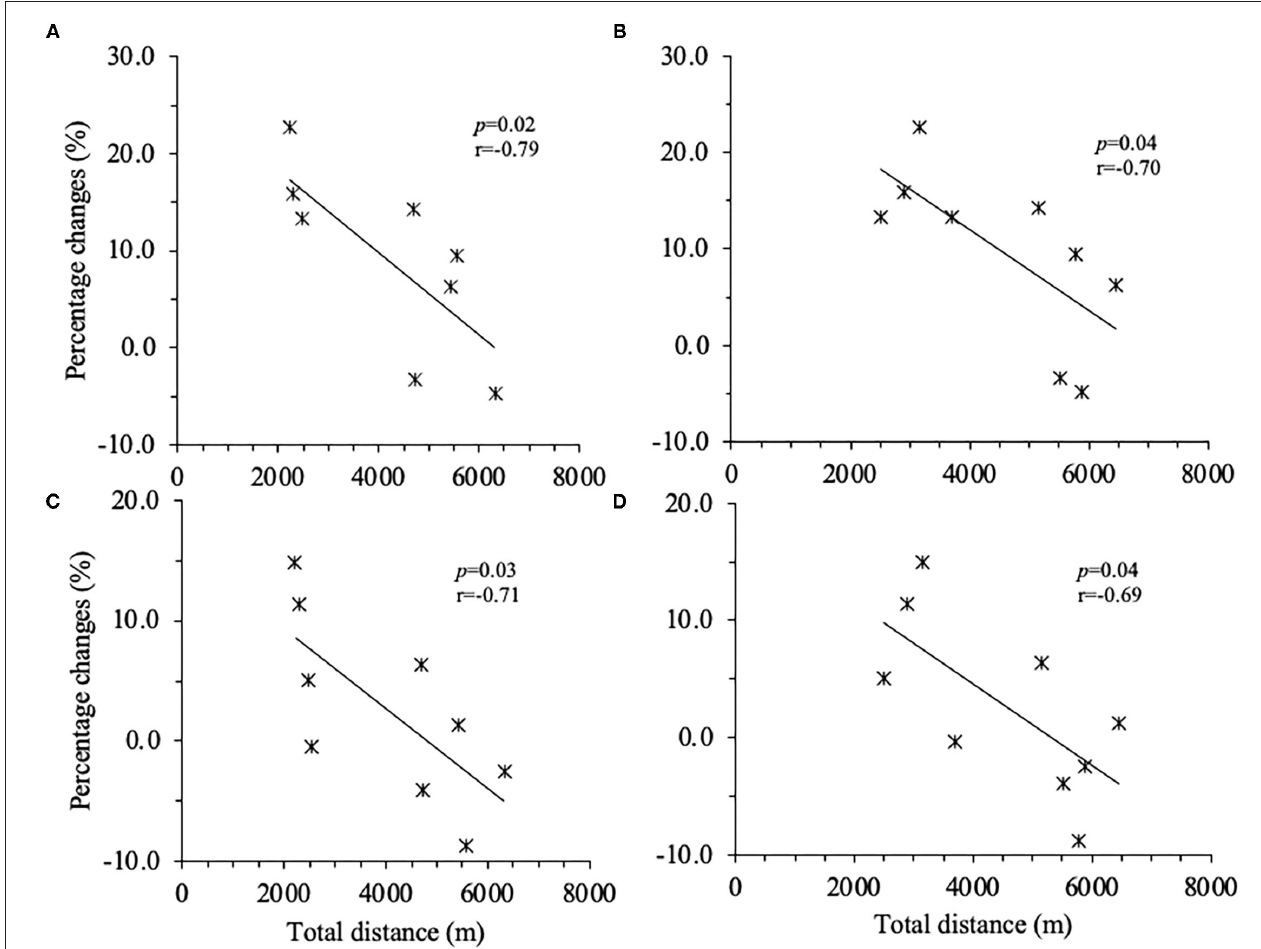
FIGURE 2 | Correlations between percentage changes from 1st non-conference match-play to 6th conference match-play inunloaded countermovement jump (CMJO) jump height and peak power and total distance. (A) Between jump height and D 7 total distance, (B) between jump height and D 21 total distance, (C) peak power and D 7 total distance, and (D) peak power and D 21 total distance. D 7 = average of 7 days. D 21 = average of 21